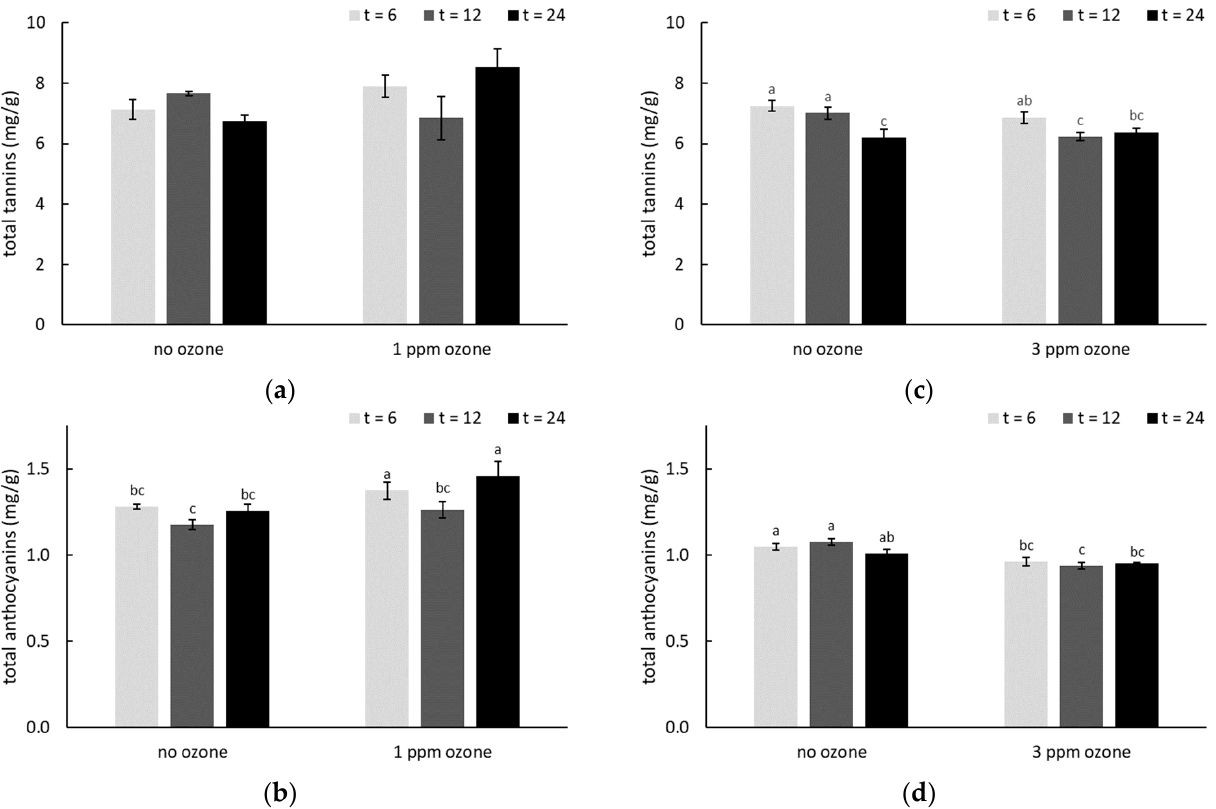
Figure 3. Total tannin and anthocyanin concentrations (mg/g) in smoke-affected grapes, with and without post-harvest ozone treatment (at ( a , b ) 1 or ( c , d ) 3 ppm for 6, 12 or 24 h).Values are means of three replicates ( n = 3). Different letters indicate statistical significance ( p = 0.05, one ‐ way ANOVA); ns = not significant. Post ‐ harvest smoke treatments were applied on consecutive days, but smoke density was lower on the second day of treatment due to increased wind.